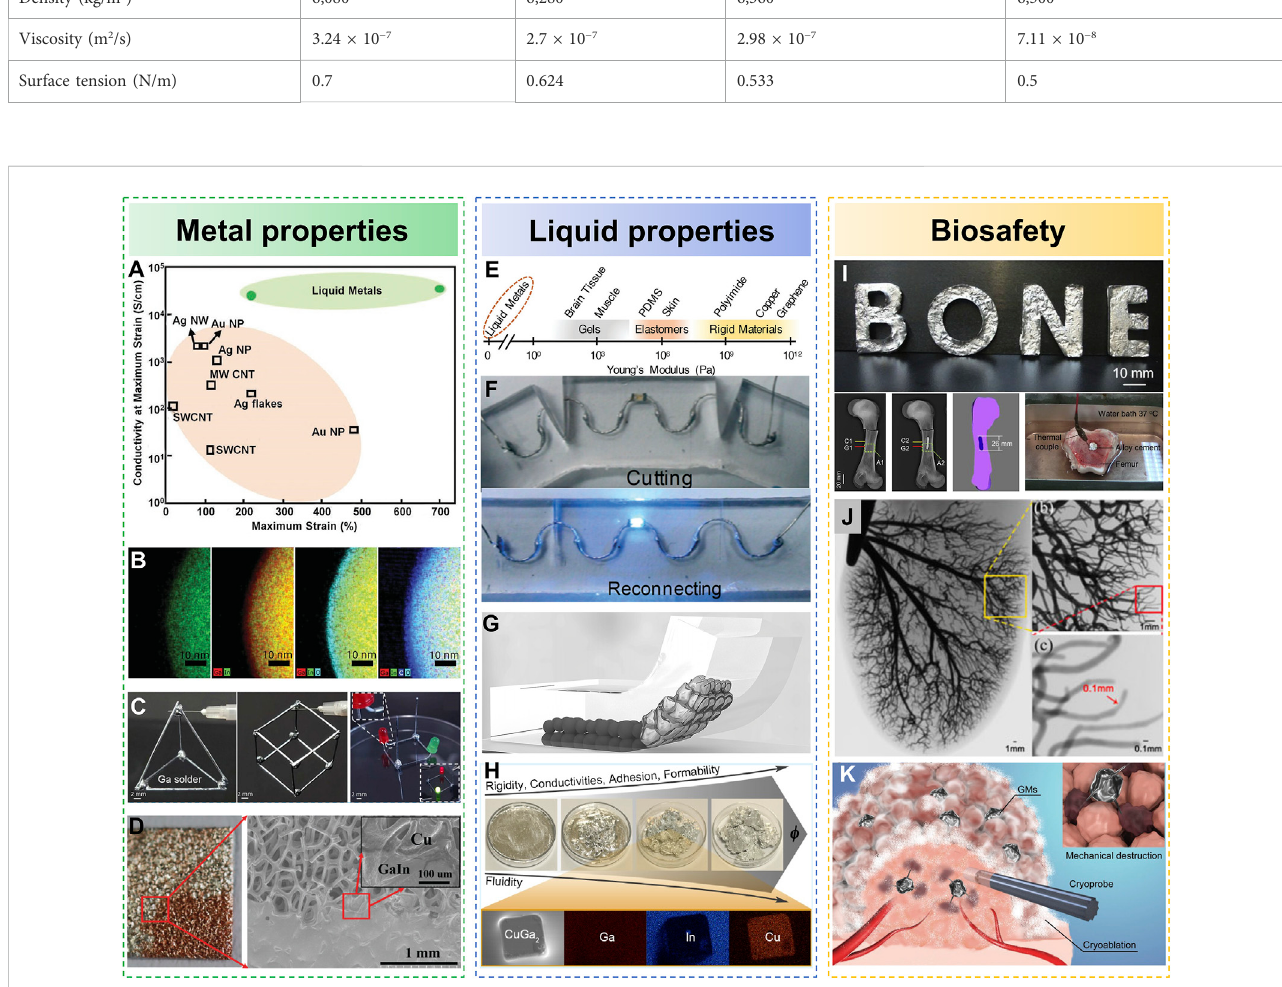
The unique properties of LM. (A) The conductivity of LM is compared with other common fl exible conductive materials (Wang et al., 2018c). Copyright@ 2018, Wiley (B) Oxide fi lm on the surface of LM (Lin et al., 2015). Copyright@2015, Wiley (C) The solid-liquid phase transition of LM is used for welding three- dimensional circuits(Wangetal.,2022b).Copyright@2022,Elsevier (D) WettingofLMonthesurfaceofporouscopper(Maetal.,2018).Copyright@2018,RSC (E) Young ’ s modulus of LM is compared to that of common fl exible materials (Wang et al., 2018b). Copyright@ 2018, Wiley (F) Self healing of LM in micro channels (Li et al., 2016). Copyright@2016, RSC (G) Conductive composite based on LM micro nano particles (Tang et al., 2018). Copyright@2018, Cell Press (H) Semi LM with low fl uidity (Tang et al., 2017). Copyright@ 2017, ACS (I) Bone cement 247 based on LM (Yi et al., 2014). Copyright@ 2014, Elsevier (J) LM is used for angiography (Wang et al., 2014). Copyright@ 2014, IEEE (K) LM microparticles phase change medicated mechanical destruction for enhanced tumor cryoablation (Sun et al., 2020a). Copyright@ 2020,